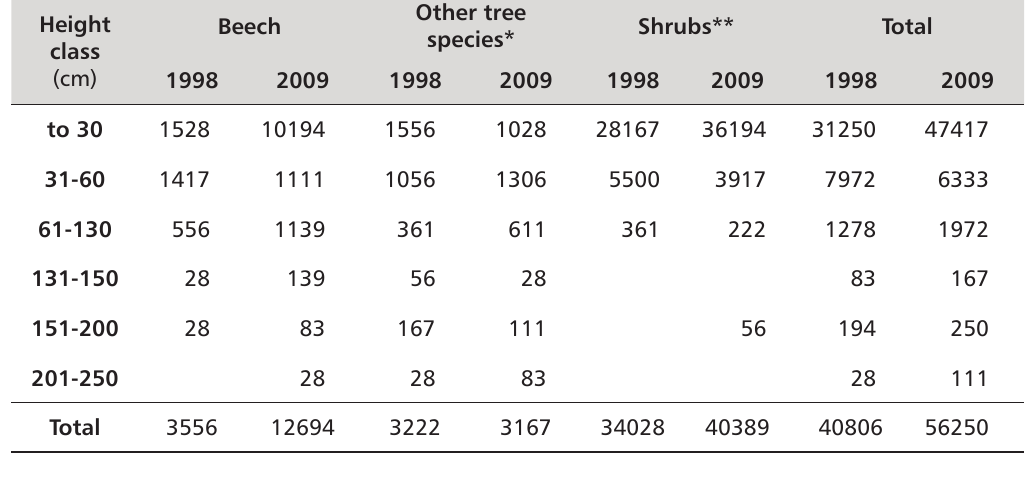
FIGURE 6. Height structure of young beech growth